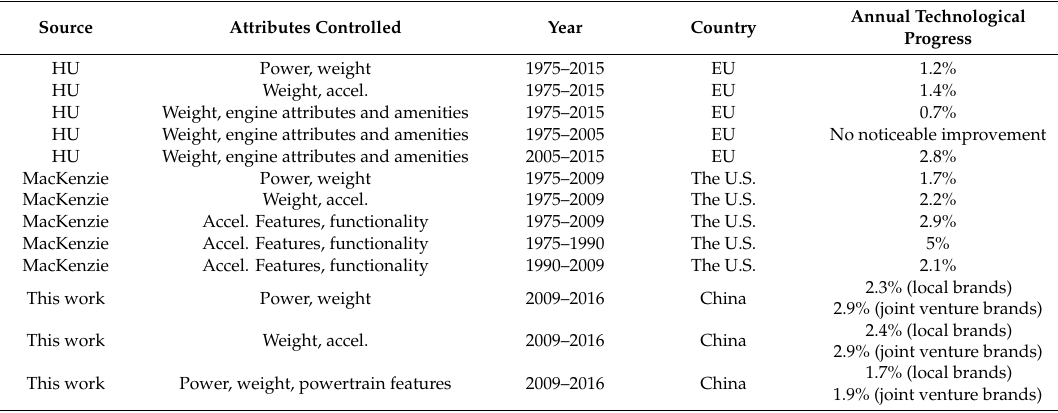
Table 3. Comparison of annual technological progress between the results of this work and other studies.